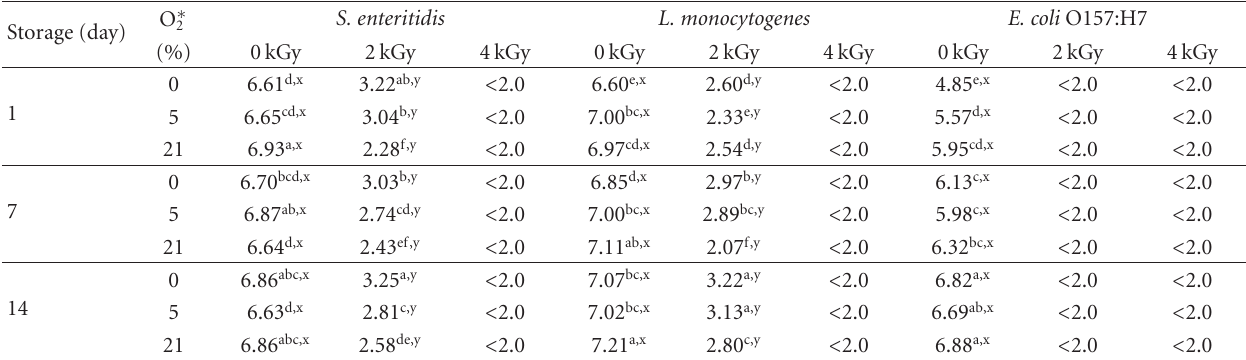
Table 1: Changes in S. enteritidis , L. monocytogenes , and E. coli O157:H7 counts (LogCFUg − 1 ) in ready-to-cook meatballs during storage at 3 ◦ C as a ff ected by irradiation dose (kGy) and O 2 levels in 0% CO 2 containing